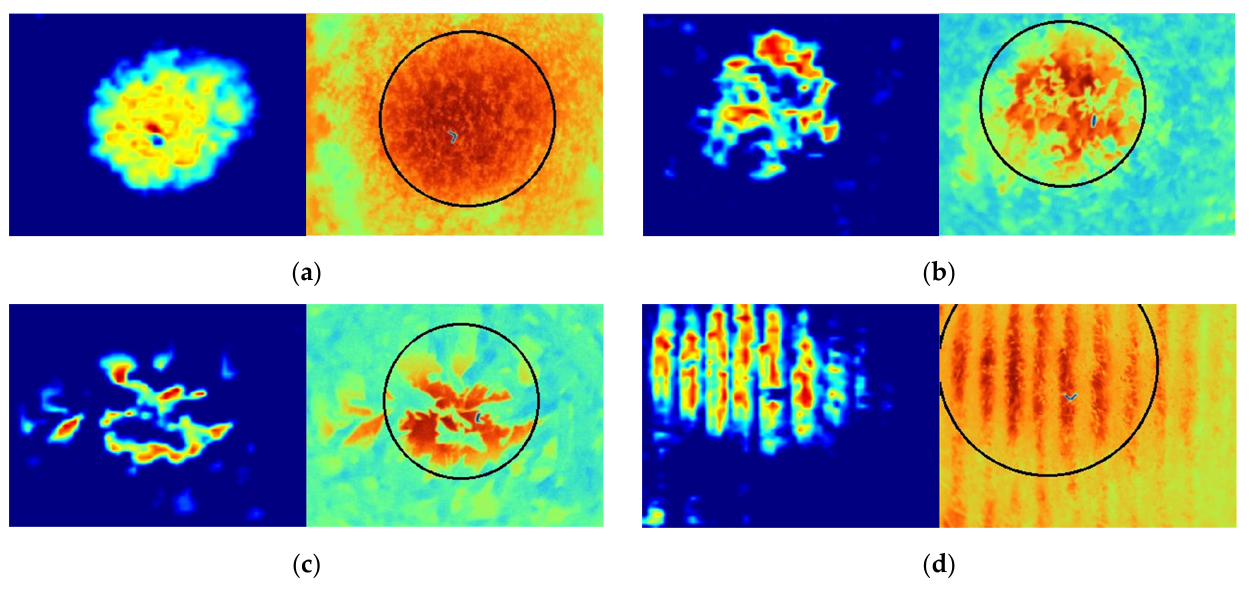
Figure 9. Visualization of the used areas in random input images for classifier: ( a ) grass; ( b ) soybean; ( c ) corn and ( d ) wheat. Each image from left to right is the visual heat map based on Grad-CAM and the heat map fitting circle.